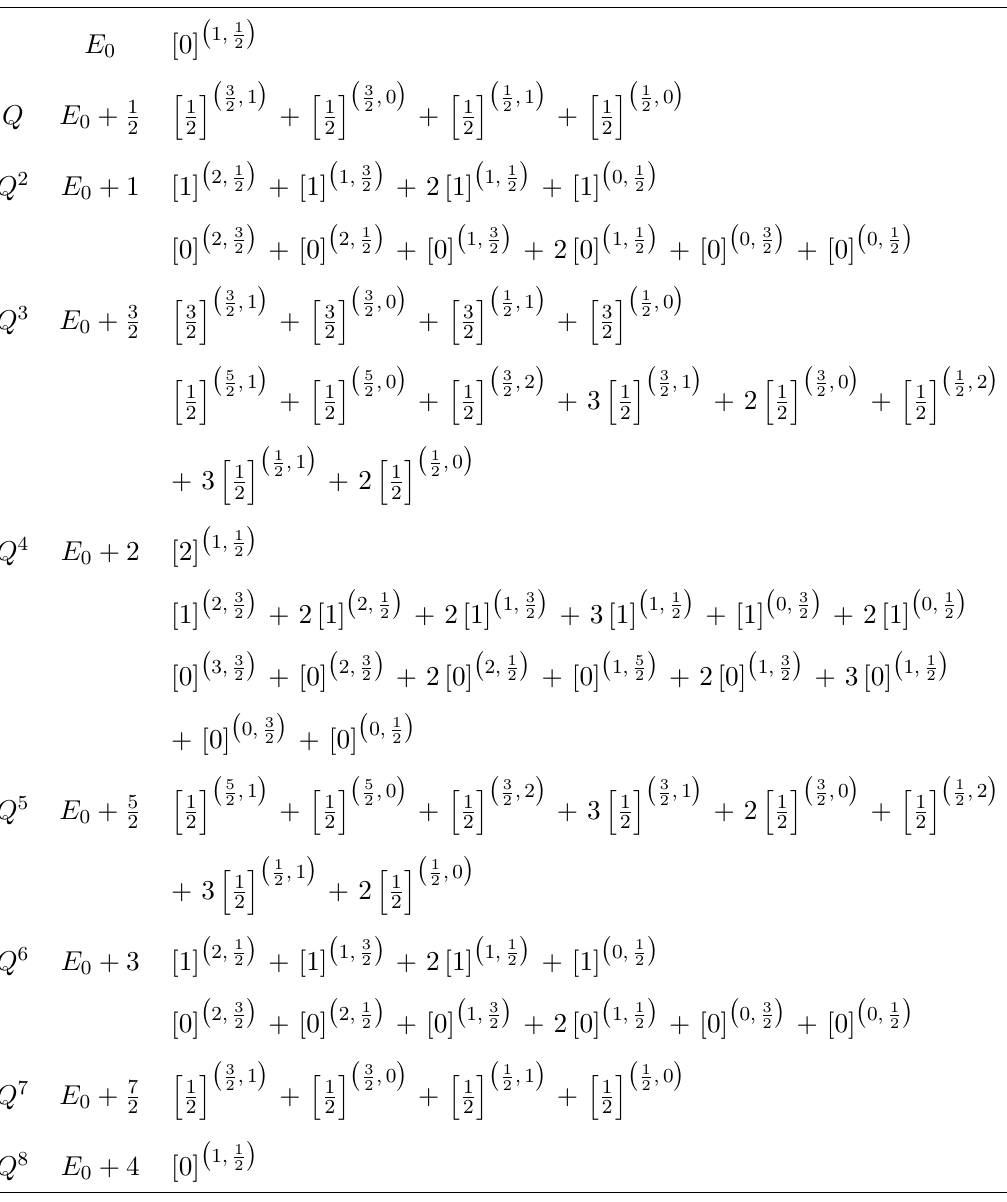
(cid:2) (cid:3) E 0 , 1 , 1 2